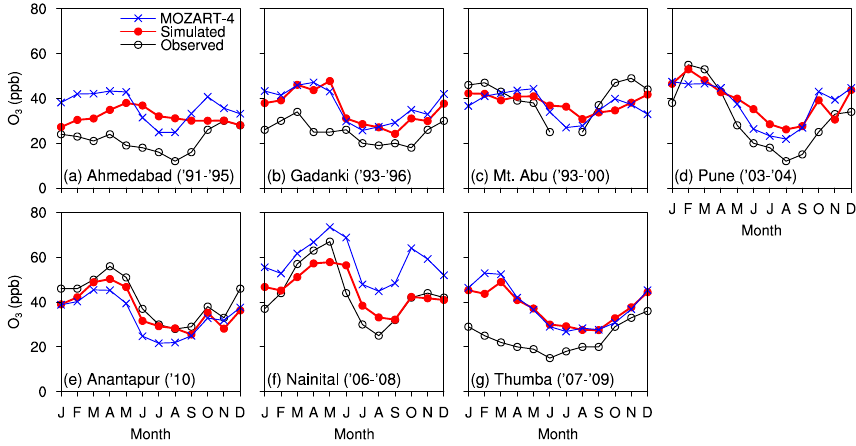
Figure 4. Monthly mean observed and simulated surface ozone concentration in BASE for 2010 at seven sites in India. Results of MOZART-4 are also shown. Target years of observations are shown along site